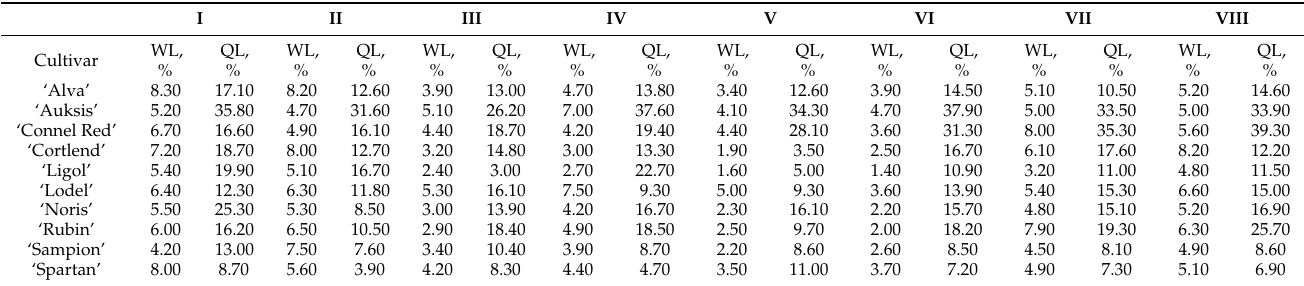
Table 6. Variability in quality and weight loss in apples during storage in